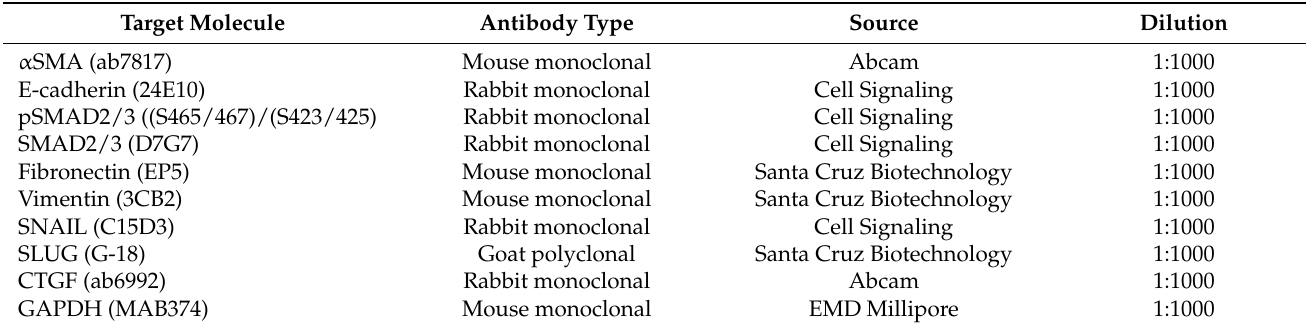
Table 2. List of Antibodies Used for Western Blot